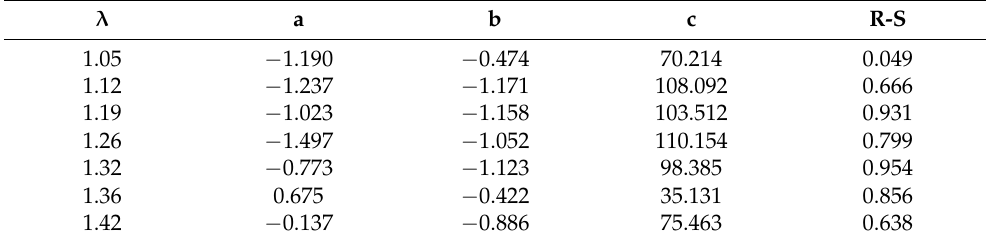
Table 8. Fitting parameters of CA90 and PMAX distribution under different λ